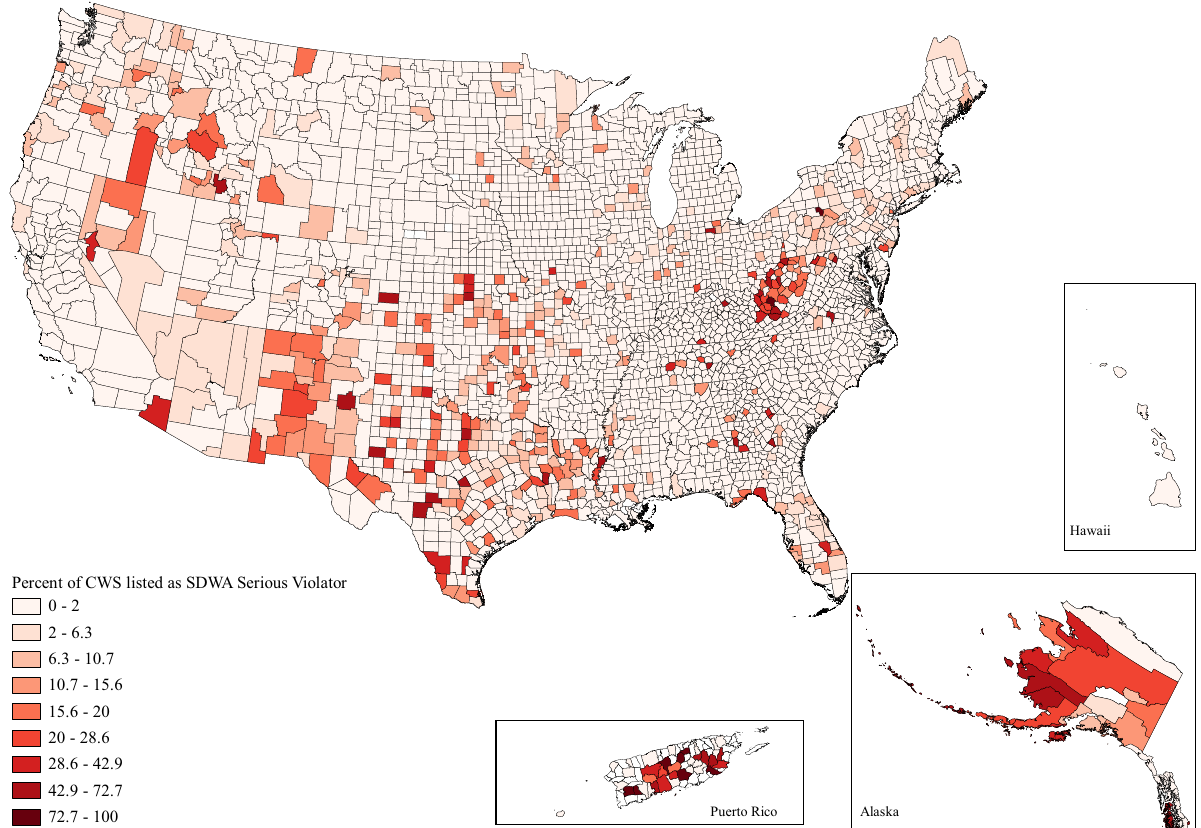
Fig. 2 Map of the percent of active county community water systems listed as Safe Drinking Water Act (SDWA) Serious Violators. Safe Drinking Water Act Serious Violators are those community water systems regarded by the Environmental Protection Agency as the most problematic due to violation and compliance